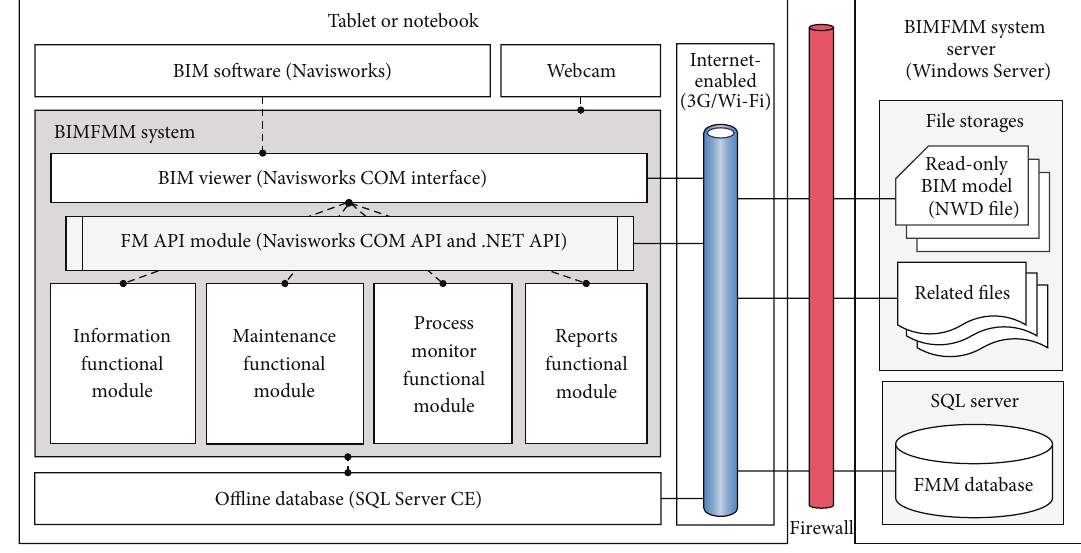
Figure 1: Overview of the BIMFMM system